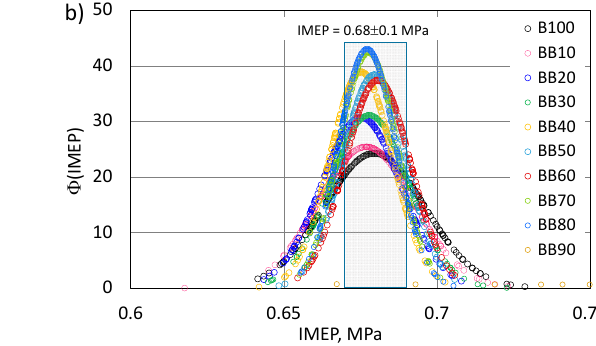
Figure 15. Correlation of maximum pressure and IMEP for DB ( a ) and BB ( b ).